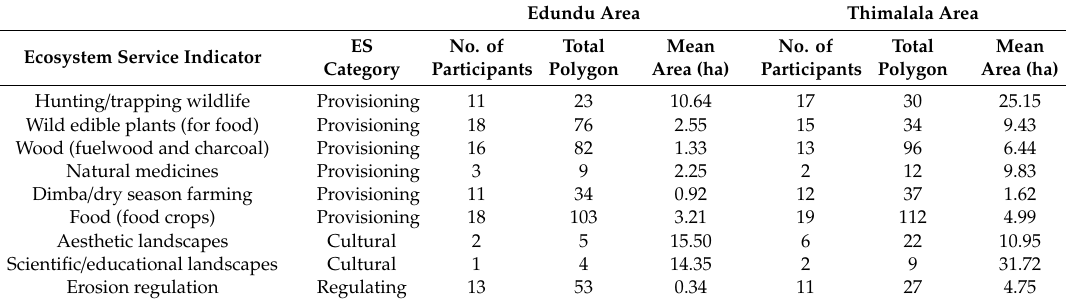
Table 7. Ecosystem service indicators and thetotal number of polygons drawn across knowledge